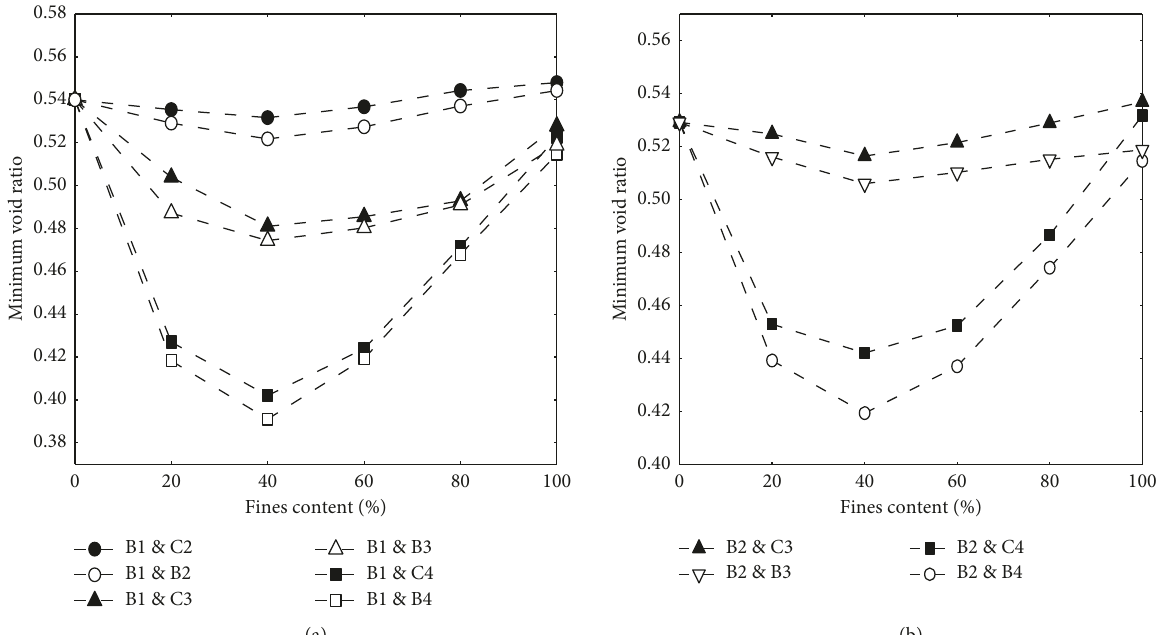
Figure 9: Measured minimum void ratios versus fines content for alternative material mixtures (SB and SB, and SB and